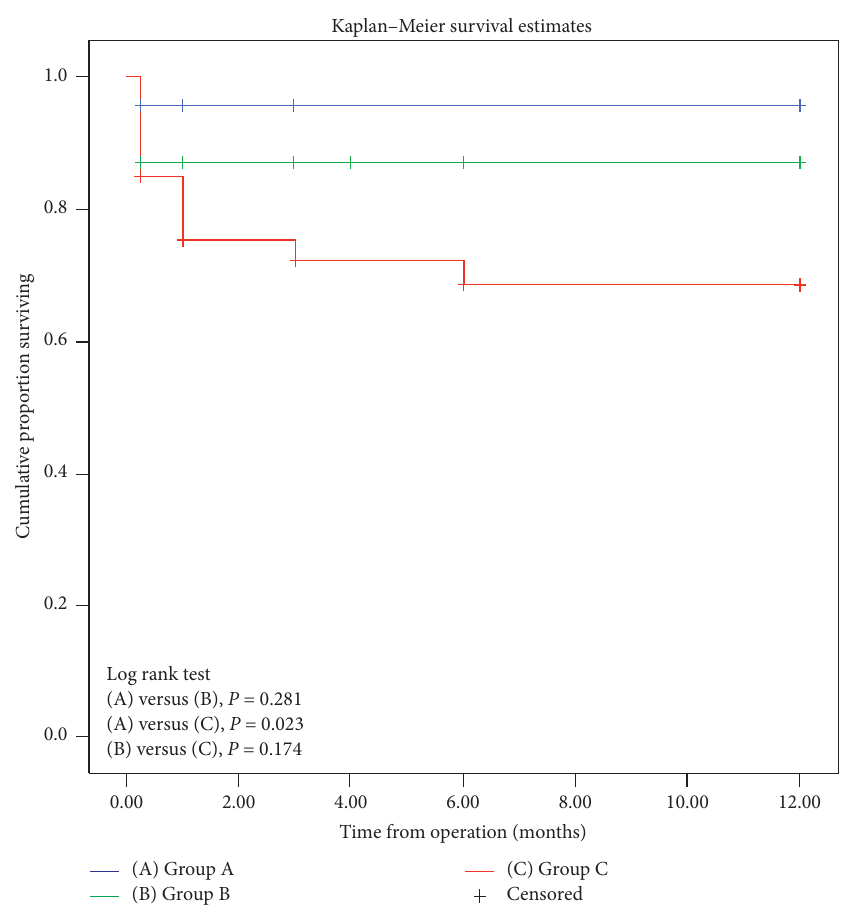
Figure 1: Kaplan–Meier survival curves for complete success after